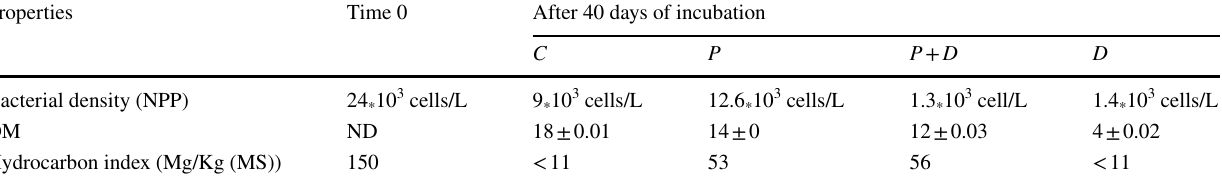
Table 5 Result of microbial load count Properties